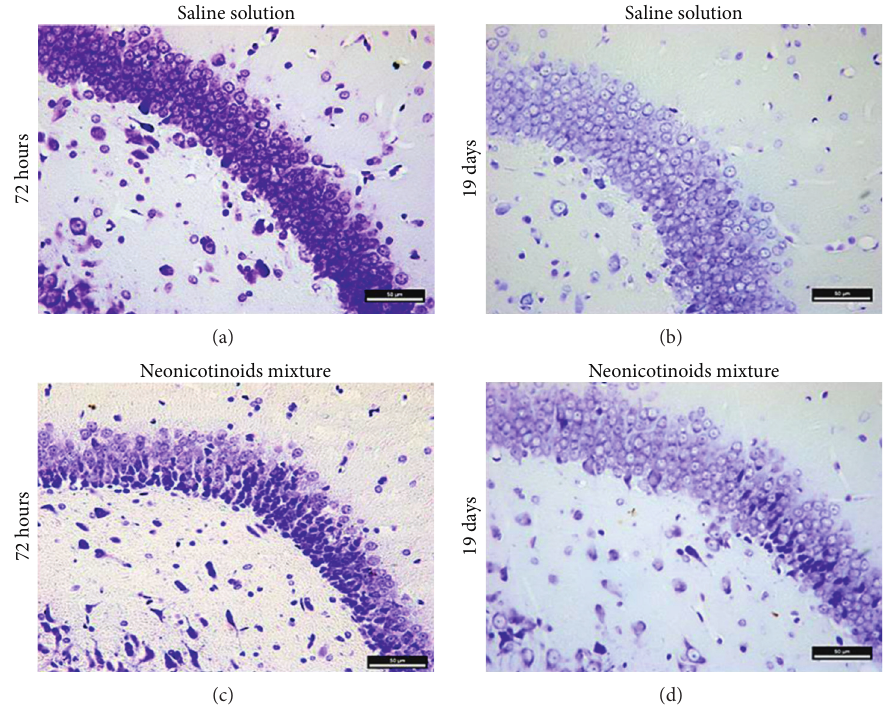
Figure 3: (a) Neuronal damage produced by the oral administration of the neonicotinoid mixture (LD50 2/10). (b) Effect of the oral administration of saline solution observed in a magnification of 40X, showing the granular cells of DG 72 h and 19 days after the